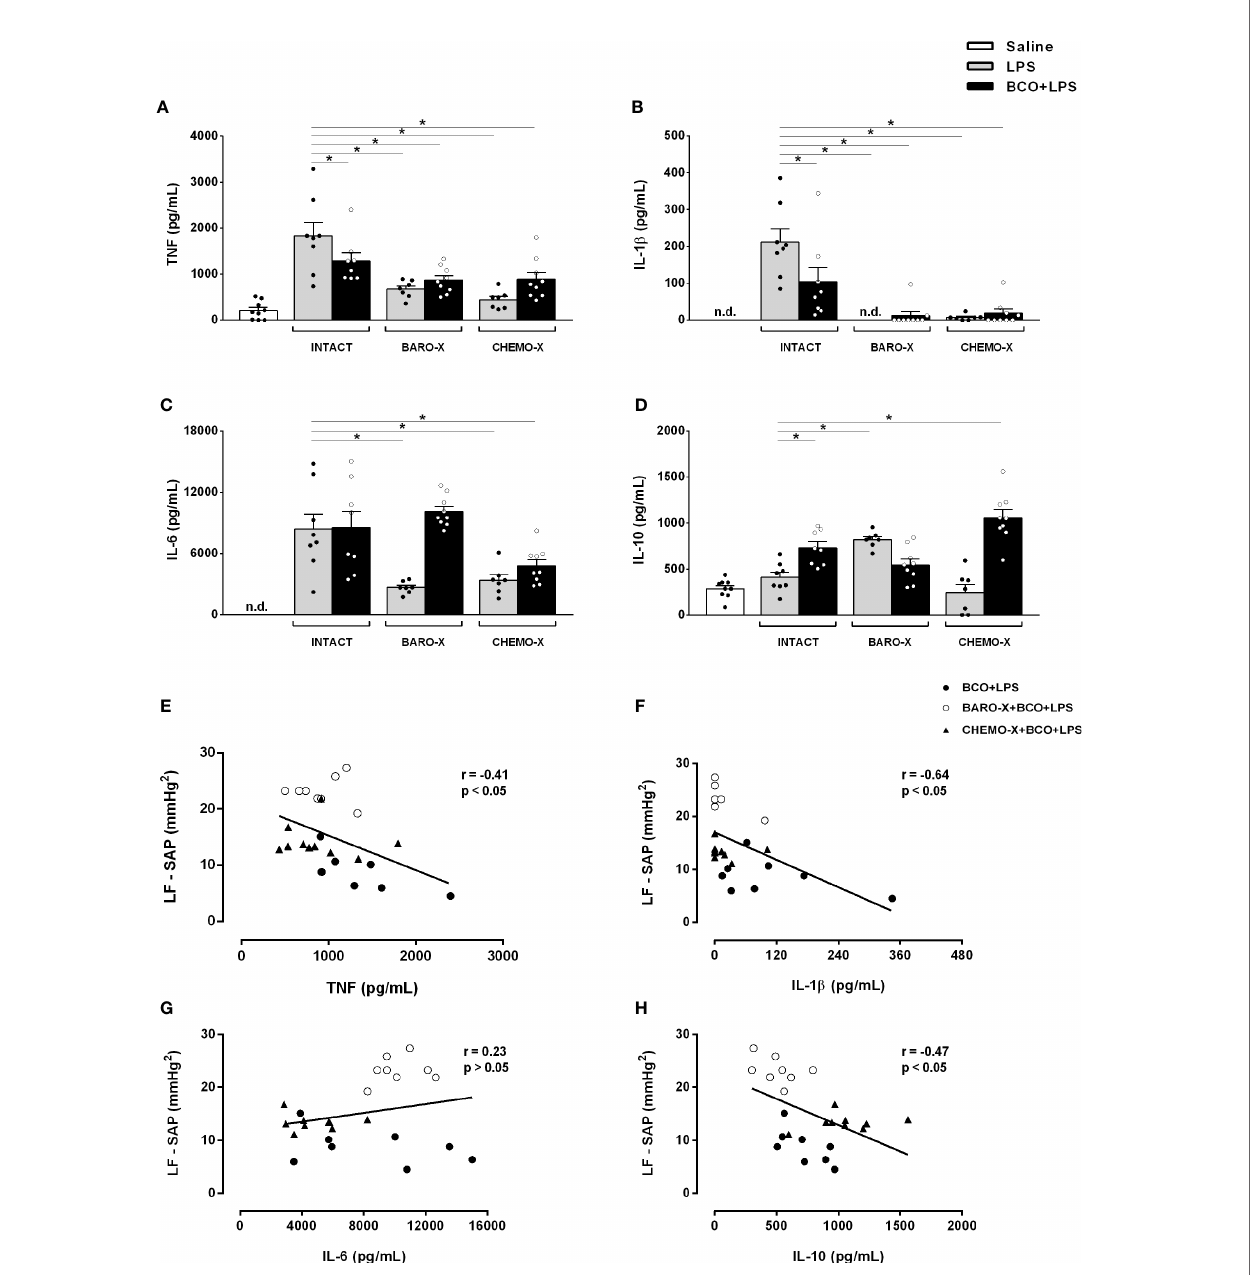
FIGURE 3 | Plasma cytokine levels 90 min after saline or LPS and correlation of systolic arterial pressure variability and cytokine levels. Plasma levels of TNF (A) , IL-1 b (B) , IL-6 (C) and IL-10 (D) 90 min after administration of LPS or saline, and Pearson ’ s and Spearman ’ s correlation between the power of the low-frequency band of the systolic arterial pressure (LF-SAP) during the BCO period and the cytokines plasma levels [TNF (E) , IL-1 b (F) , IL-6 (G) , and IL-10 ( H )] at 90 min after the administration of LPS. BARO-X, selective denervation of baroreceptors; BCO, bilateral carotid occlusion; CHEMO-X, selective denervation of chemoreceptors; LPS, lipopolysaccharide; n.d., not detected. Bars represent mean ± SEM. *p <